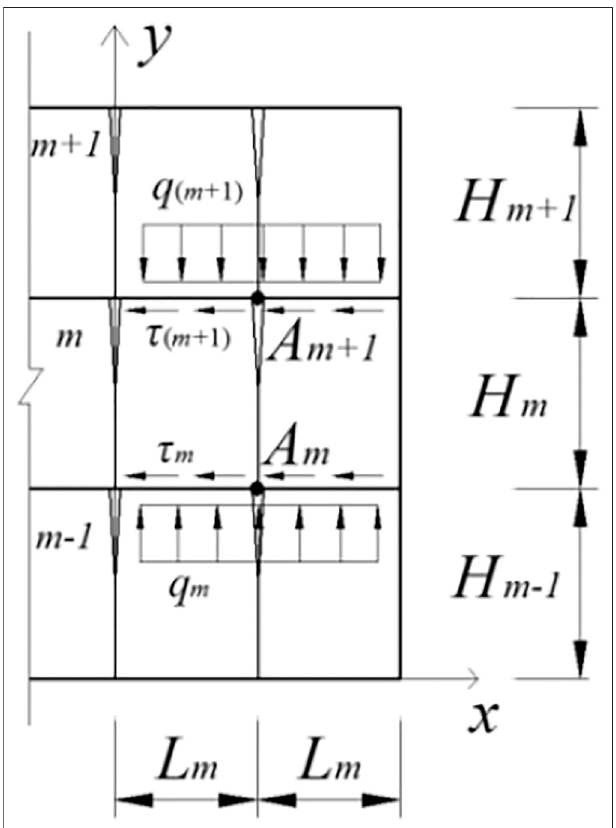
FIGURE 4 | Geometric model of interlayer interaction in a rock